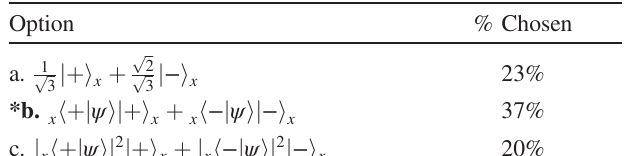
TABLE VI. Student response rate on survey 1 question 1 from Fig. 5. Answer options from Fig. 5. The correct option is bolded. Note: students could select multiple choices. Survey 1 (Pre-QBT) Which expression correctly converts j ψ i into the x basis? Circle